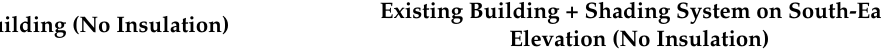
Table 5. Validation of the results: illuminance caused by daylight (Lux). Comparing real data obtained in the building with the simulations results obtained by DesignBuilder. Simulation results are divided in three categories; minimum illuminance, maximum illuminance, and the average lux entering the